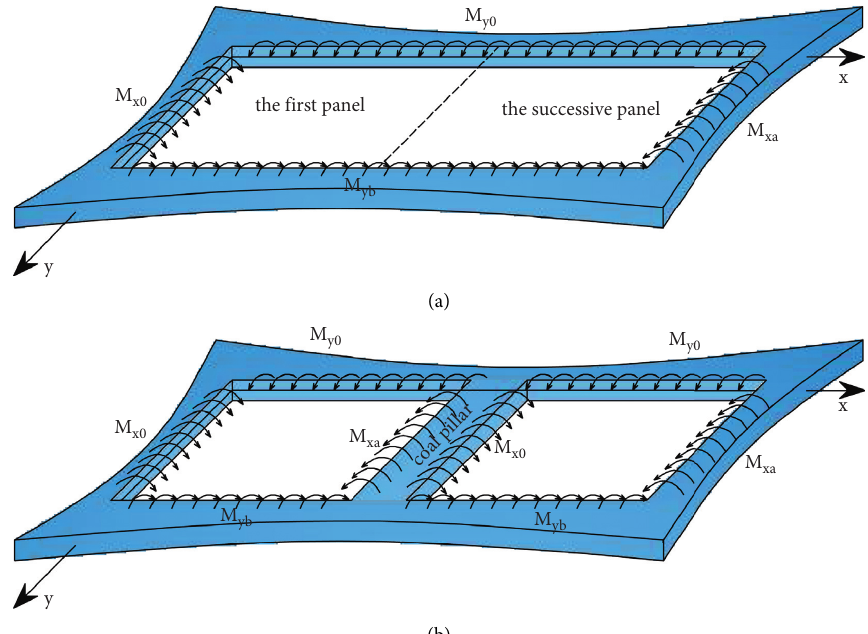
Figure 12: Mechanical models of key strata above longwall panels: (a) Mechanical model of key strata above SLL panels; (b) mechanical model of key strata above conventional longwall mining panels.